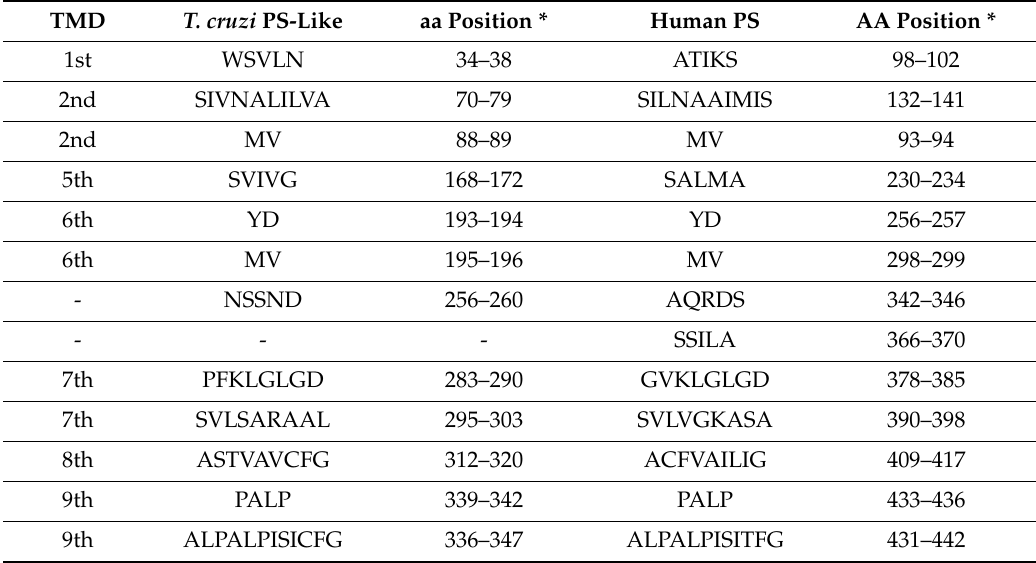
Table 2. Comparison of amino acid motifs in human PS and the T. cruzi